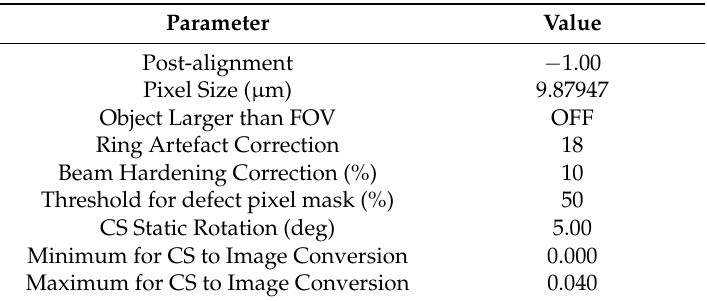
Table 4. Selected major reconstruction parameters.